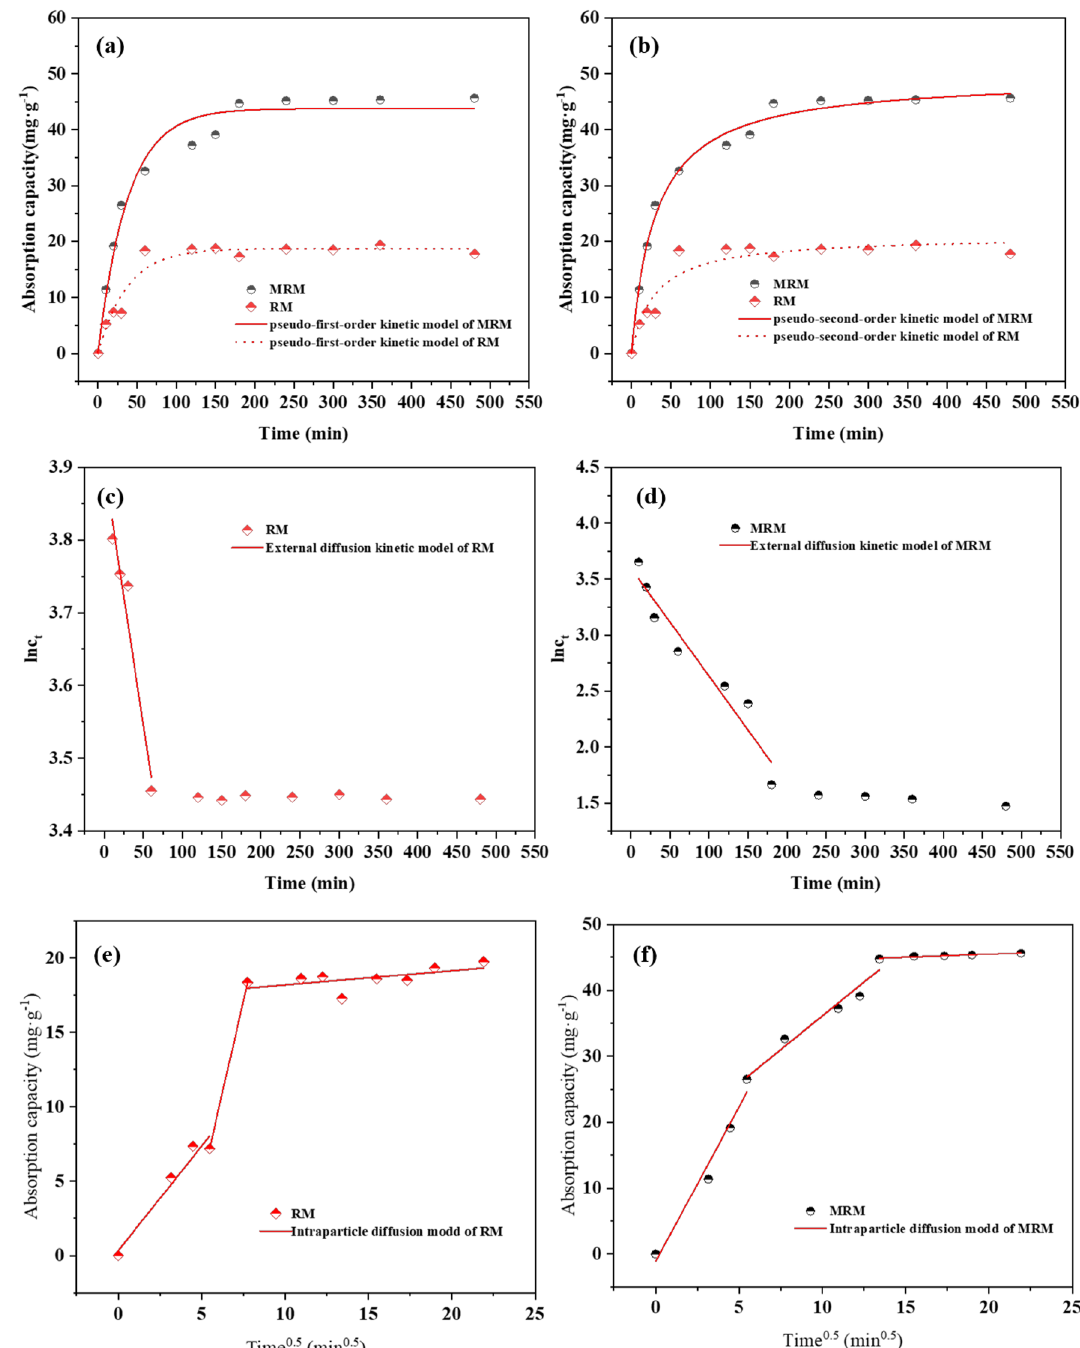
Figure 11. The pseudo-first-order ( a ) and pseudo-second-order ( b ) kinetic models for Cd 2+ adsorption on MRM and RM; The external diffusion model of Cd 2+ adsorption on MRM ( c ) and RM ( d ); The intra-particle diffusion model ( e ) of Cd 2+ adsorption on MRM ( e ) and RM ( f